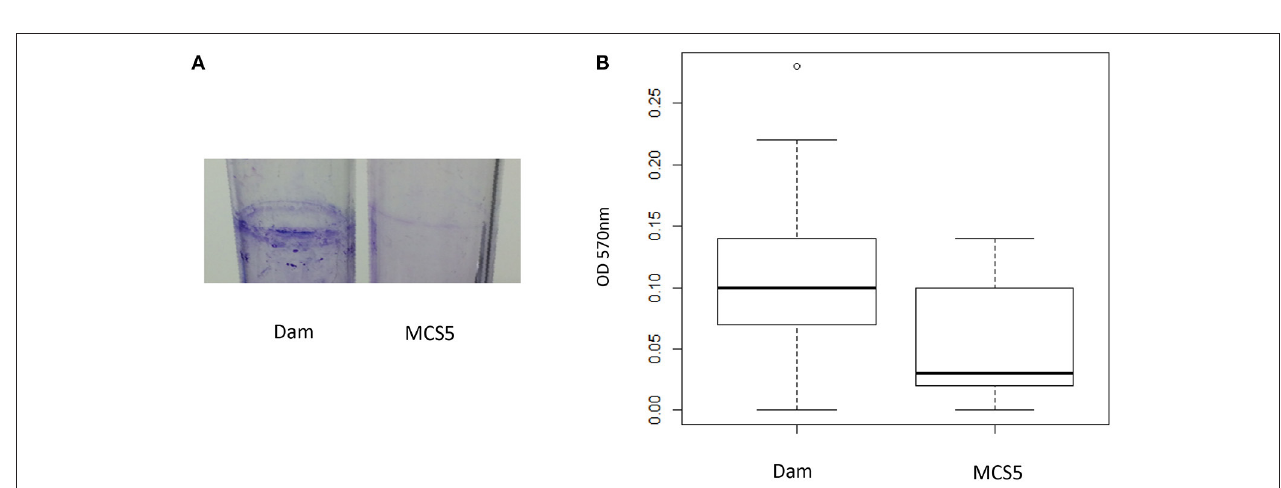
FIGURE 4 | Biofilm formation ability of P. luminescens overexpressing dam gene (Dam) and control (MCS5). (A) Biofilms formed in a glass tube after 12 days of incubation in LB medium were stained with crystal-violet. (B) Boxplots of the biofilm-associated crystal violet measured at OD 570 nm (see Methods section for details). Difference between the two strains is significant ( p < 0.01, Wilcoxon